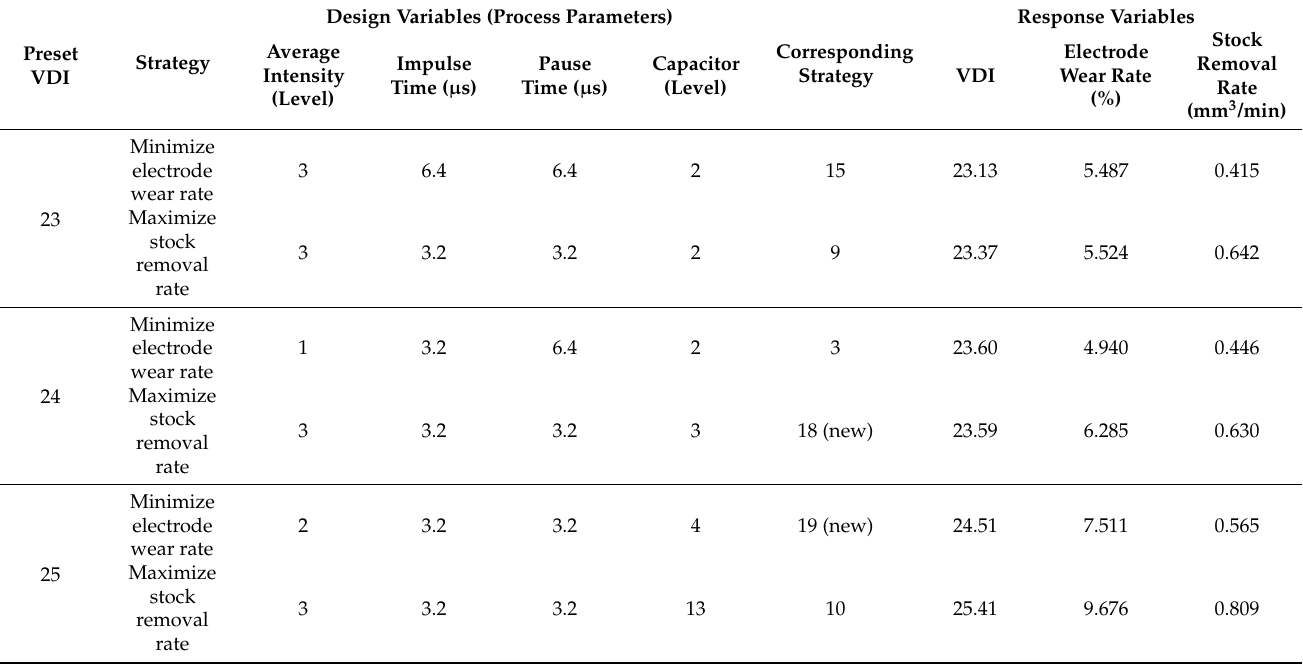
Table 10. Optimization algorithm results.